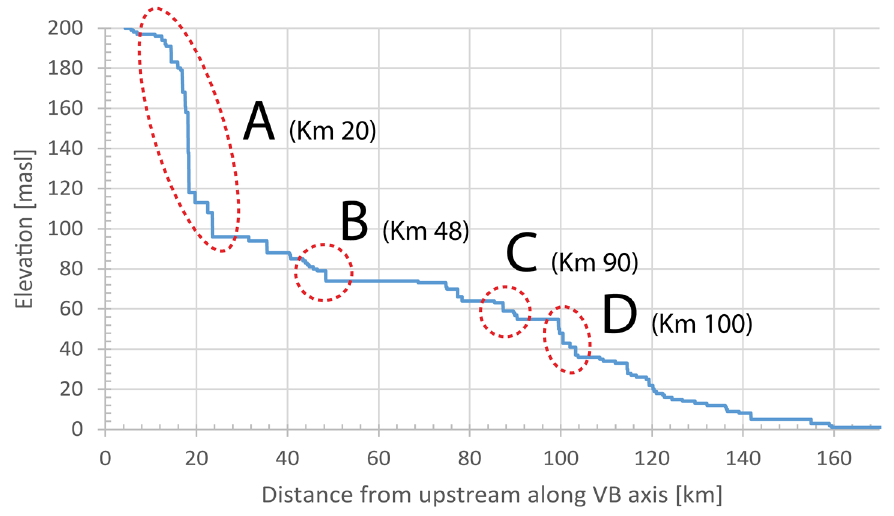
Figure 12. Baker case study: approximate elevation of the VB along the river axis (from USGS Earth Explorer, Digital Elevation: GMTED2010, Entity ID: GMTED2010S50W090, 11 November 2010).